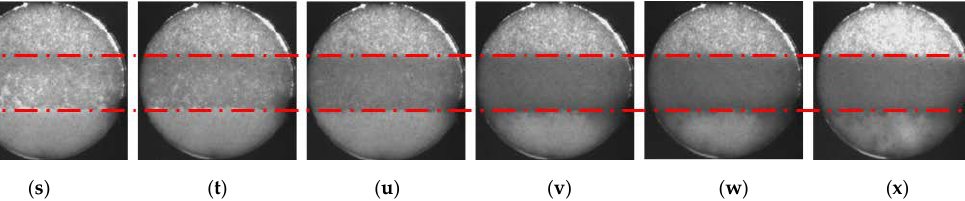
Figure 6. Gas–oil interface migration during CO 2 -assisted gravity drainage. ( a ) 0.01 HCPV, ( b ) 0.04